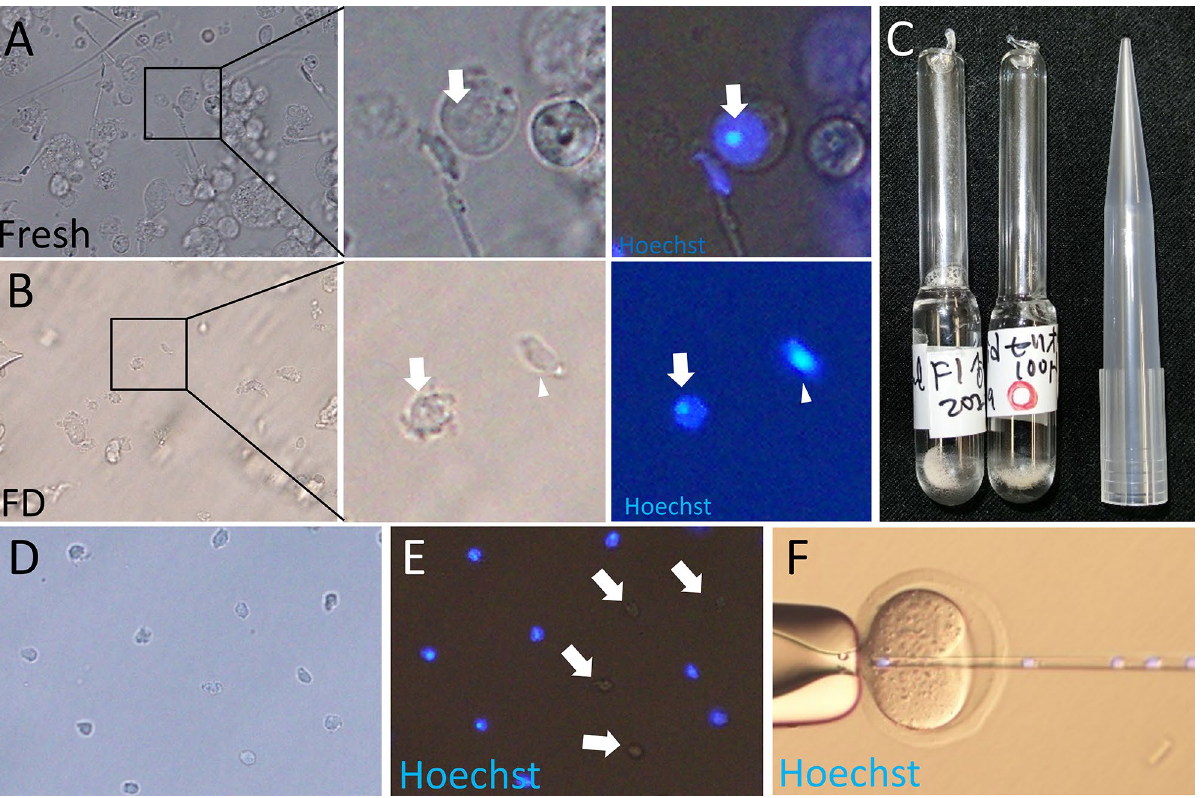
Figure 1. Detection of spermatids after FD treatment. ( A ) Fresh round spermatid. ( B ) Rehydrated FD spermatid. The middle section shows high magnification and the right section shows the fluorescent observation of the nucleus. The arrow shows the chromocenter. The arrow head shows an elongated spermatid. ( C ) Glass ampoules of mouse FD spermatids. ( D , E ) Collection of FD spermatids assessed as such morphologically ( D ), and fluorescent observation of FD spermatids ( E ). The arrow shows cells without nuclei. ( F ) FD spermatids were injected into fresh